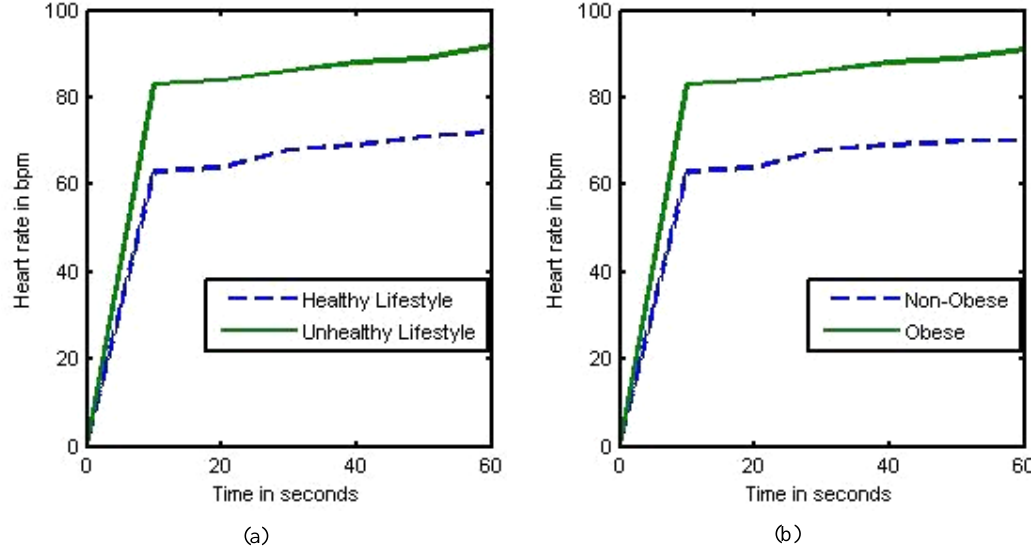
Figure 6. (a) Healthy lifestyle vs. unhealthy lifestyle, and (b) non-obese vs.